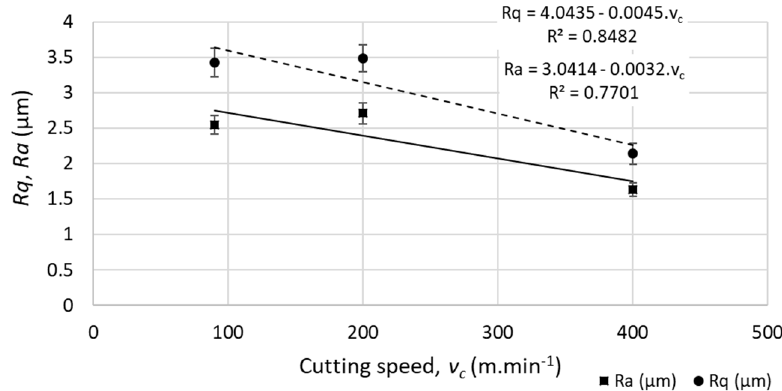
Figure 6. Example of profile roughness parameters ( Ra— average roughness of the profile, Rq —root-mean-square roughness of the profile) for different cutting speed (at feed per tooth f z = 0.05 mm). The parameter R 2 reflects the level of statistical correlation.